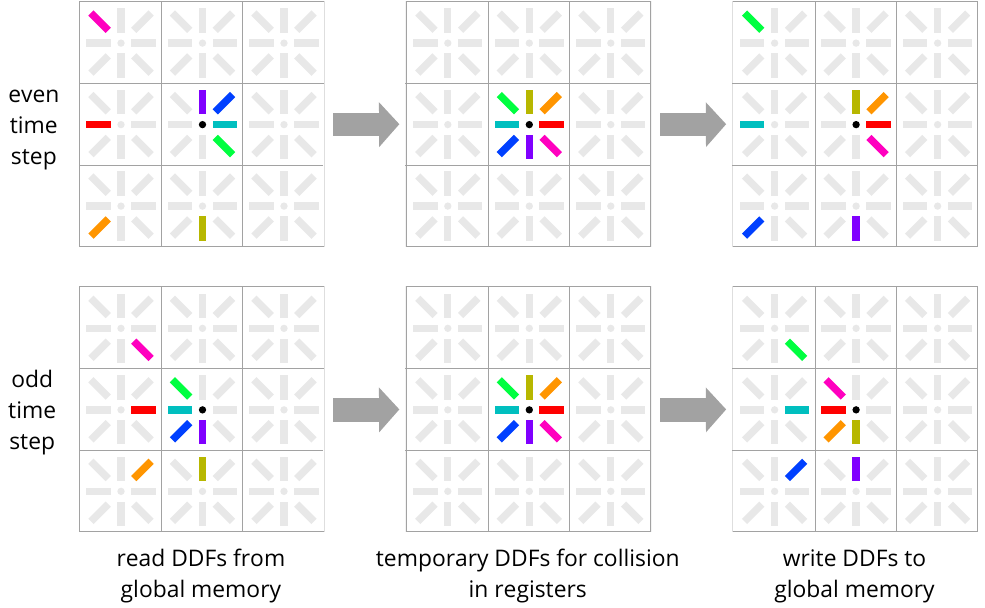
Figure 6. Esoteric Push in-place streaming scheme. Figure 5 flipped by 180 degrees (except for the temporary DDFs in